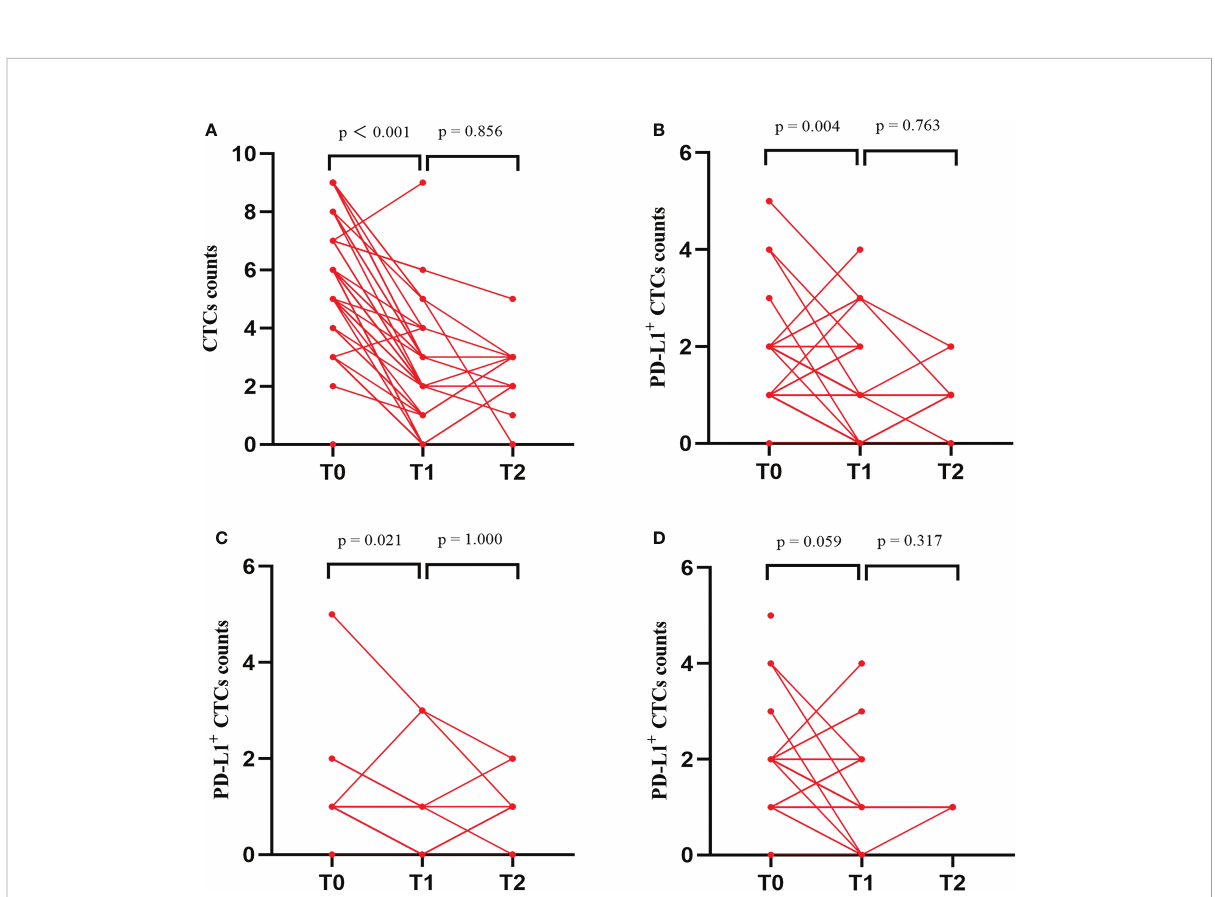
FIGURE 5 Changes in total CTC counts, PD-L1 + CTC counts and proportion of PD-L1 + CTC counts at baseline (T0), 1 months (T1), and 3 months (T2) after the beginning of triple therapy. (A) CTC counts in total enrolled patients. (B) PD-L1 + CTC counts in total enrolled patients. (C) PD-L1 + CTC counts in responders. (D) PD-L1 + CTC counts in nonresponders. PD-L1, programmed death-ligand 1; CTCs, circulating tumor cells.